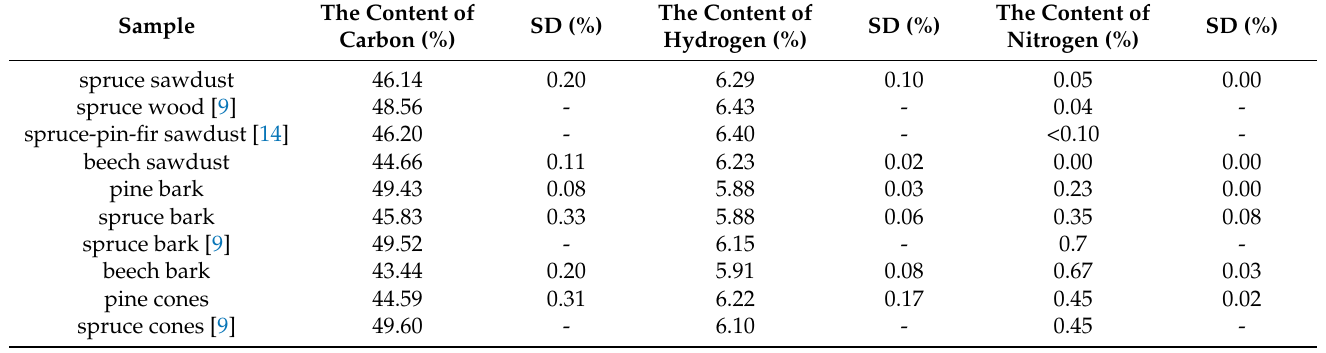
Table 2. Results from elemental analysis of various uncompressed materials.